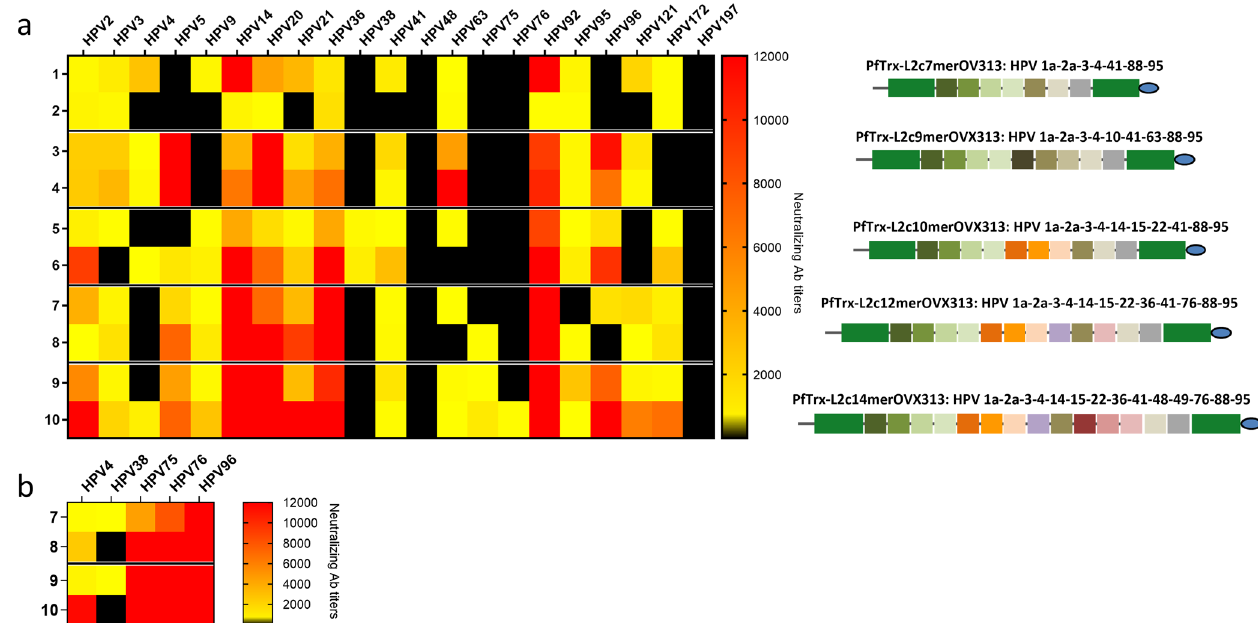
Fig. 7 PfTrx-L2c12merOVX313 and PfTrx-L2c14merOVX313 antigens induced neutralizing antibodies against 19 cutaneous HPV types in guinea pigs. a Neutralizing antibody titers to the 21 indicated HPV types measured by the L1-PBNA in sera from two guinea pigs immunized with 30 µg of the fi ve indicated PfTrx-L2-OVX313 antigens. Antibody titers ranging from 50 to 12,000 are color-coded in yellow to red; black color indicates EC50 values <50 (no neutralization). b Neutralizing antibody titers to fi ve HPV types (indicated on the top) measured by the FC- PBNA in sera from two guinea pigs immunized with 30 µg of the PfTrx-L2c12merOVX313 and the PfTrx-L2c14merOVX313